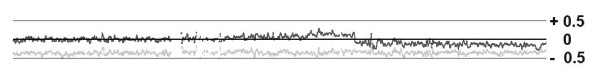
Relative magnitude of LR changes in diploid and tetraploid backgrounds. The lighter signal trace represents loss of the entire chromosome 10 in C172 where an LR of 0 corresponds to a CN of 2. In this case, a CN loss of 1 produces a LR of -0.4. In C72 where the background is largely tetraploid (the dark signal trace), a single copy loss (i.e., from CN of 4 to CN of 3) in the q-arm of chromosome 10 results in a decrease of the LR to only -0.15.